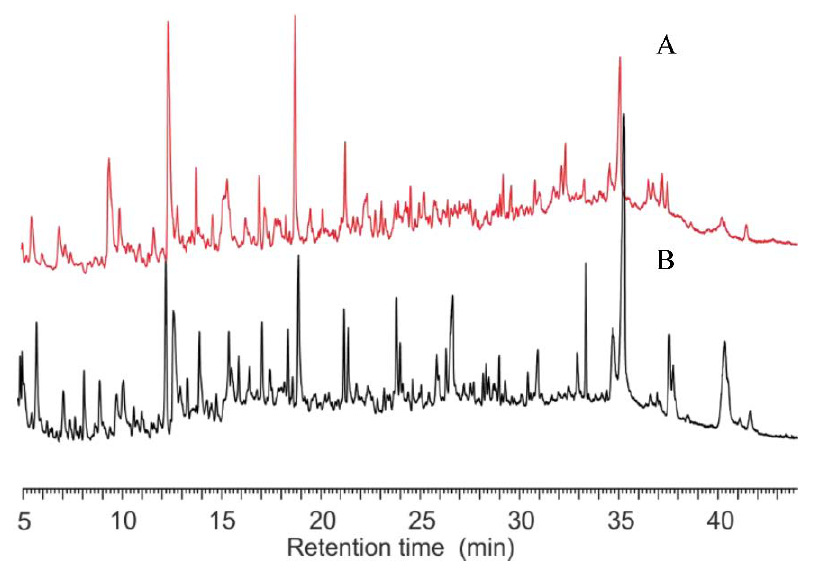
Figure 5. The characteristic peaks of A. calcoaceticus ((G − , ( A )) and S. aureus ((G+, ( B )) at 650 °C.